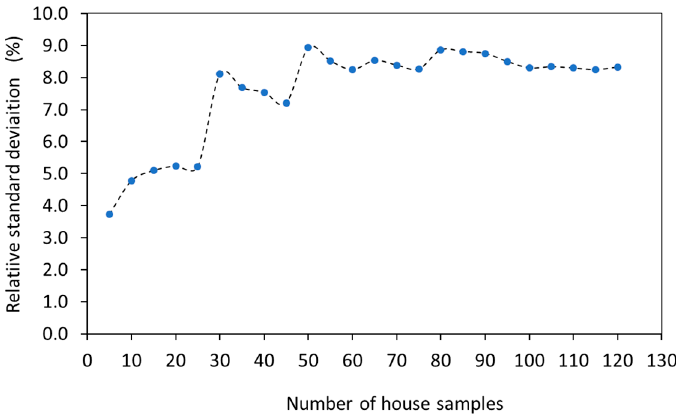
Figure 4. Relative standard deviation of average energy production by different numbers of houses that are suitable for rooftop PV application.